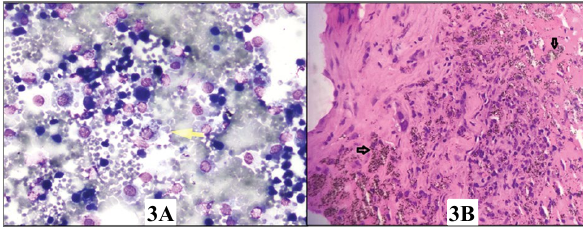
Figure 2: Bronchoalveolar Lavage in a patient with Diffuse Alveolar Hemorrhage. Serial aliquots (labeled 1 to 5) show increasing hemorrhagic return.